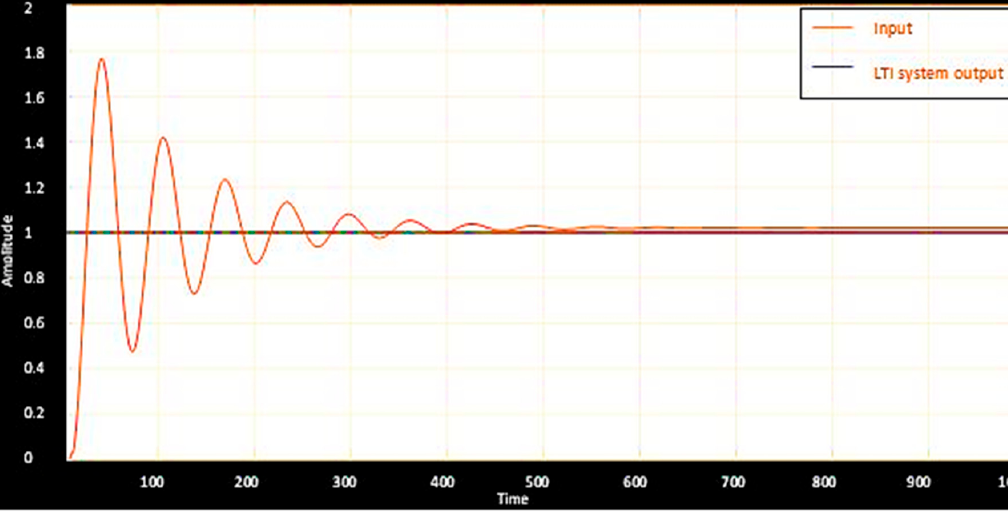
Figure 11. Estimation using Kalman filter for a step signal. Table 2. Performance errors.